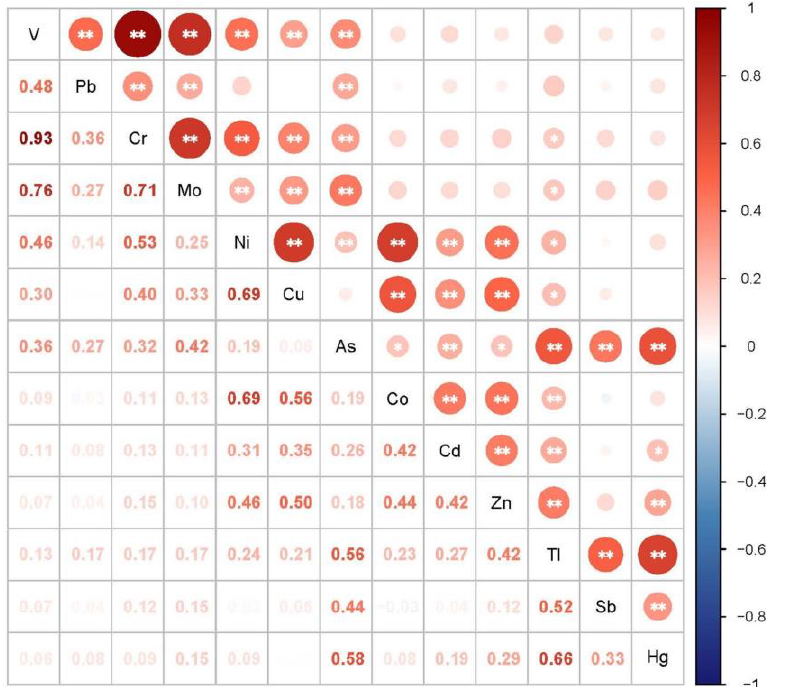
Figure 5. Correlation analysis of the contents of 13 PTEs in the soil samples ( n = 134). Note: ** represents a significant correlation at the 0.01 level (bilateral), * represents a significant correlation at the 0.05 level (bilateral).